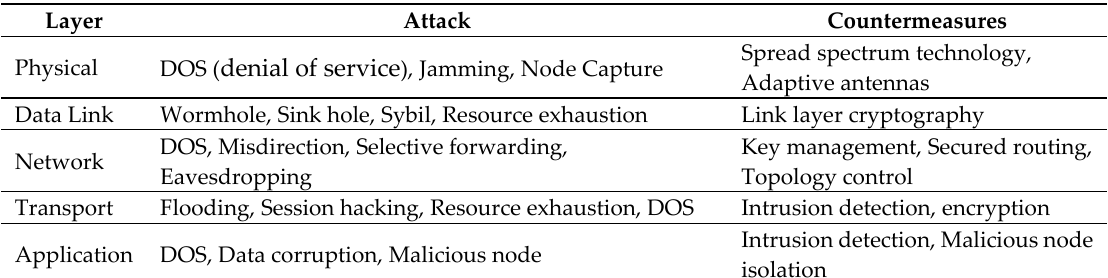
Table 3. Various cyber ‐ attacks in WSN and their